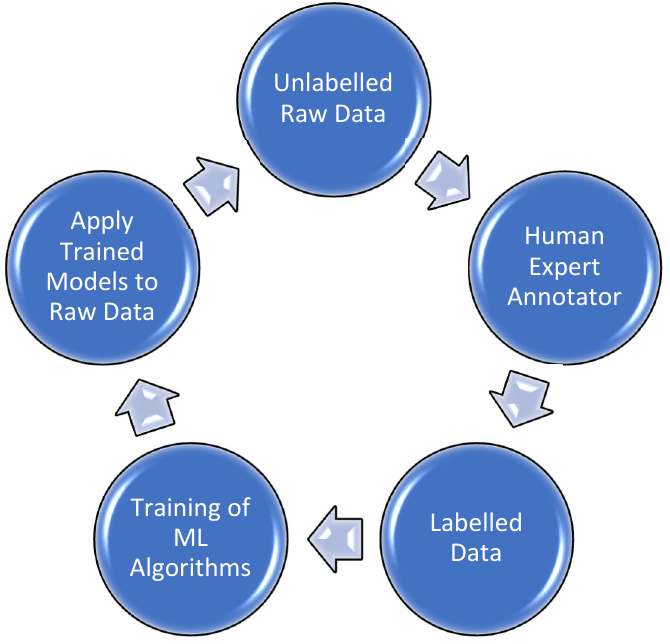
Figure 2. Schematic diagram of AL as an iterative process which help labelling the raw data.